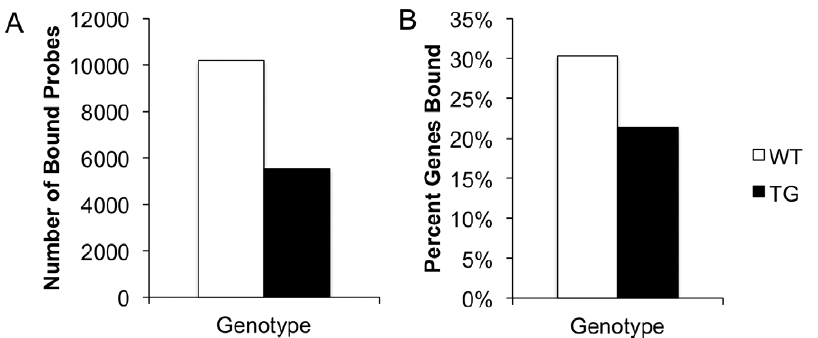
Figure 1. AcH3 interactions at gene loci are decreased in TG striata. (A) The number of AcH3-bound probes in WT (white bars) and TG (black bars) striata. (B) Percent of total genes bound by AcH3 in WT and TG striata.